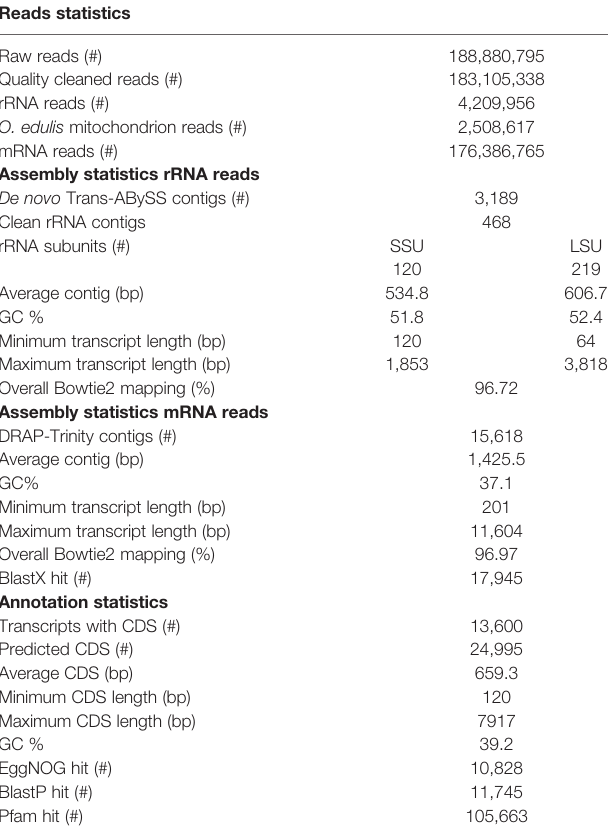
TABLE 1 | Global statistics of B. ostreae